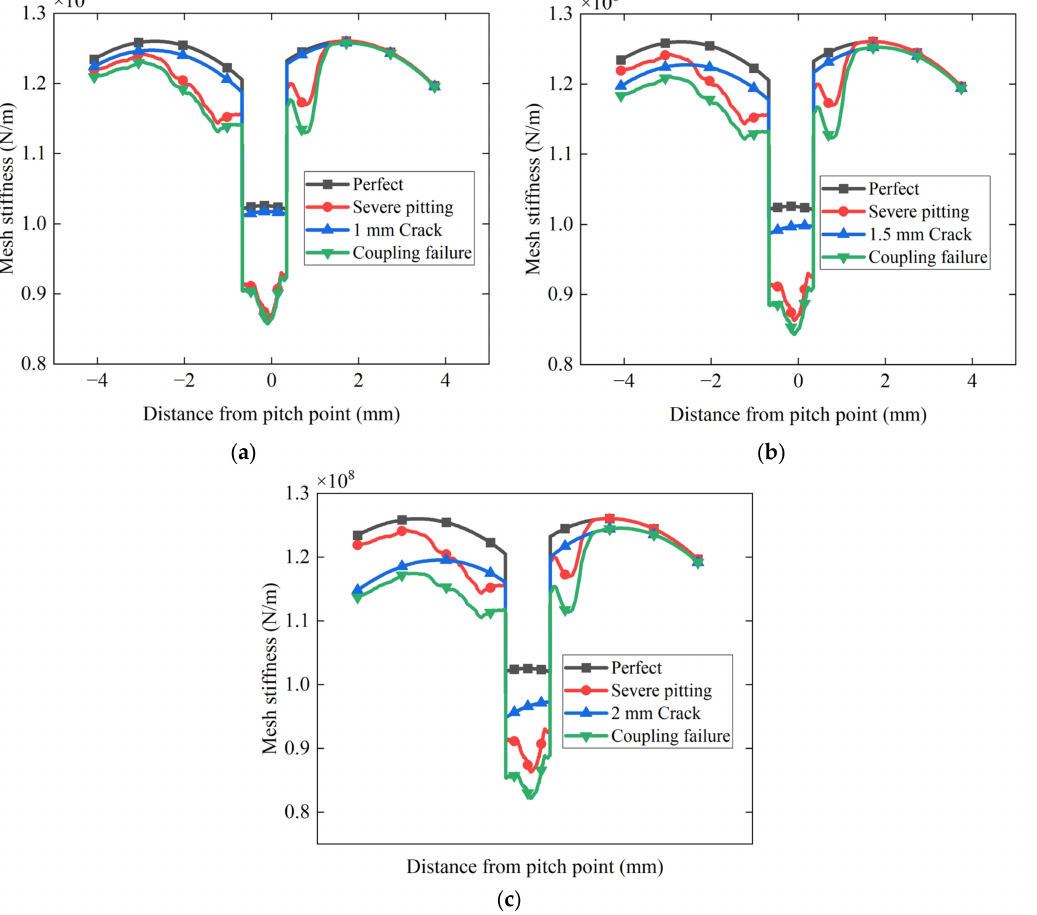
Figure 13. The crack effect on meshing stiffness with severe pitting: ( a ) At the stage of 1 mm